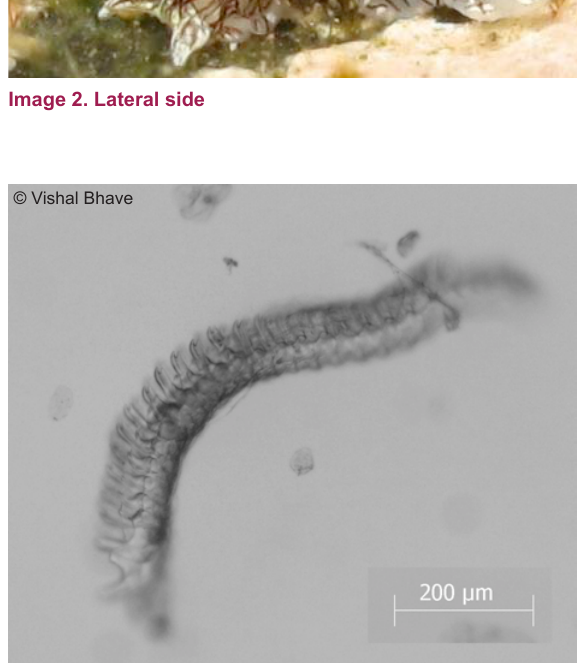
Image 4. Whole radula (light microscope